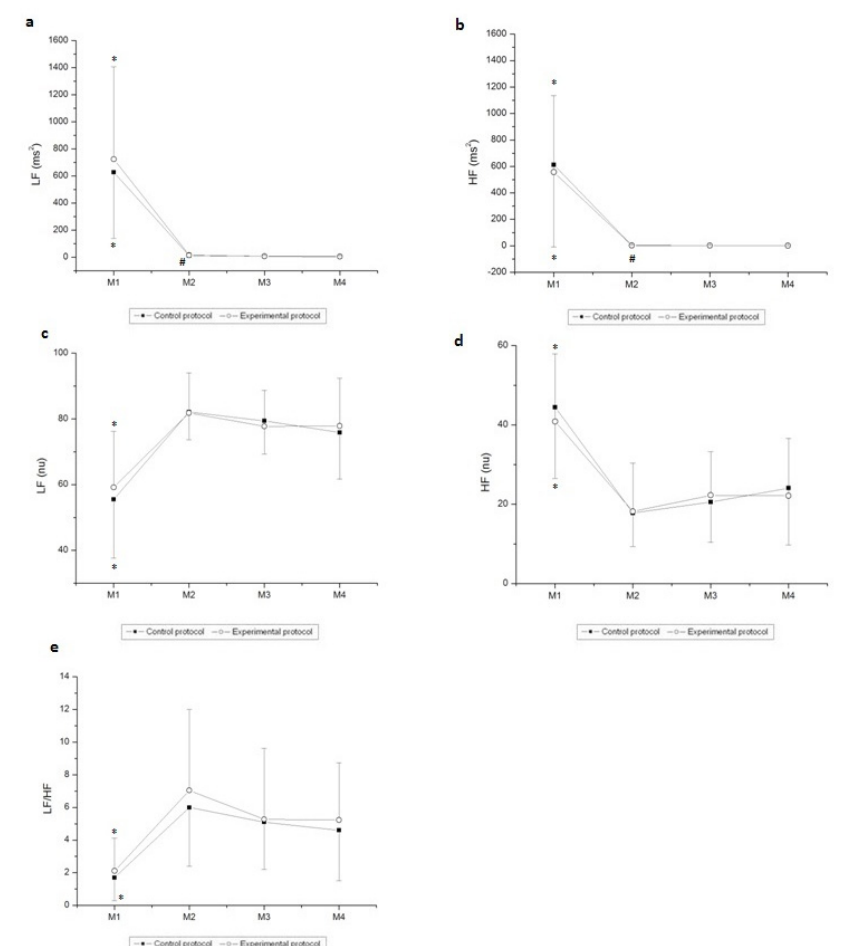
Figure 3. Values are mean ± standard deviation. ( a ) LFms 2 , ( b ) HFms 2 , ( c ) LFnu, ( d ) HFnu, and ( e ) LF/HF during exercise and the comparison in control and experimental protocols. Final 5 minutes of rest (M1) and minutes of exercise: 25–30 (M2), 55–60 (M3), 85–90 (M4). *Different from M2, M3, and M4 ( p < 0.05); #Different from M4 in the CP (LF ms 2 ) and the EP (HF ms 2 ) ( p <